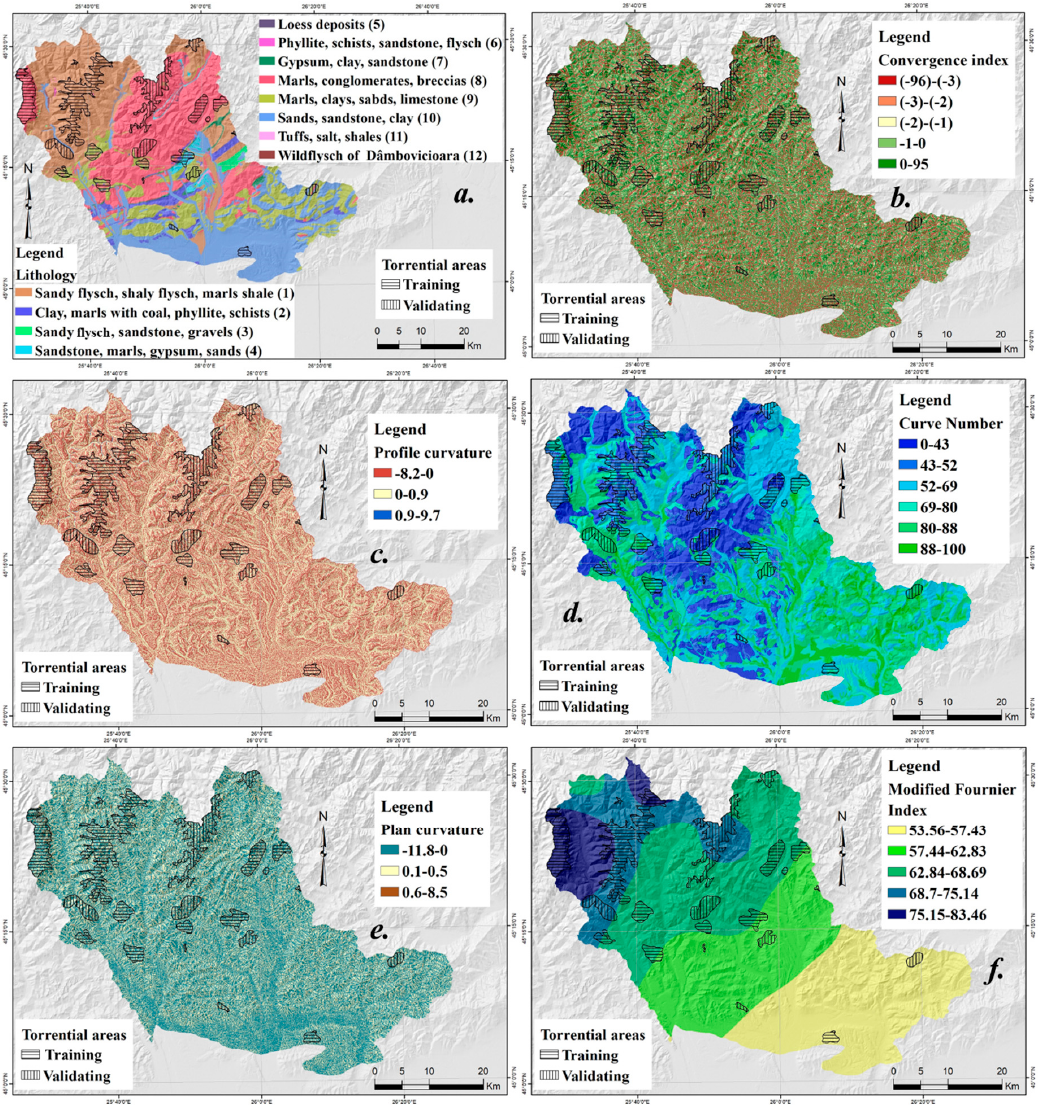
Figure 2. Flash-flood conditioning factors: ( a ) lithology; ( b ) convergence index; ( c ) profile curvature; ( d ) curve number; ( e ) plan curvature; ( f ) Modified Fournier Index.